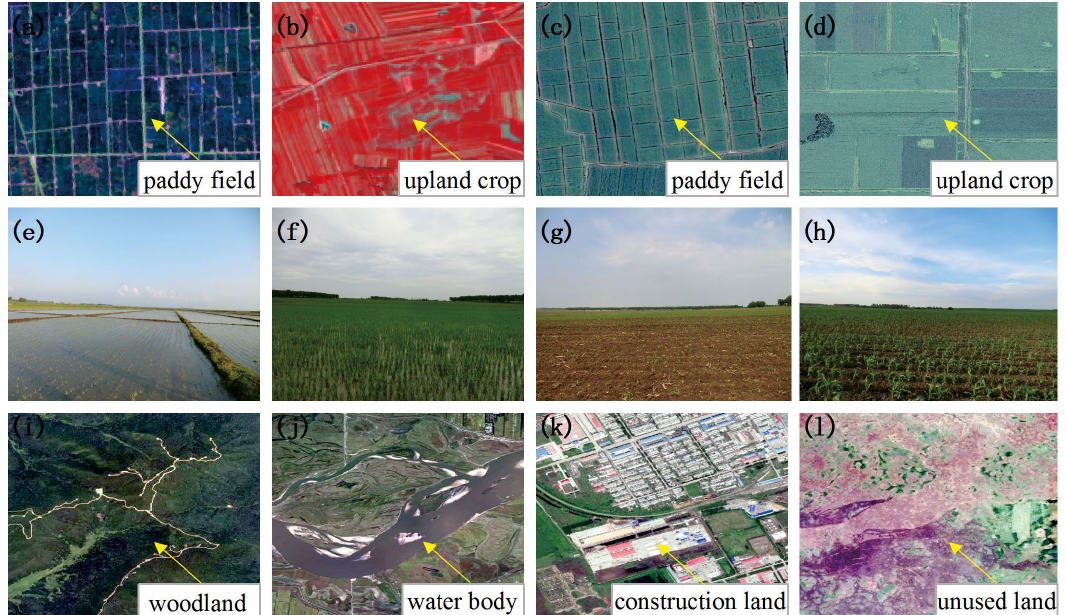
Figure 3. Validation symbols in remote sensing images and field survey photographs. ( a , b ): 30-m color composite images from Landsat TM; ( c , d ): cropping pattern (paddy field and upland crop) historical imagery archived by Google Earth; ( e , f ): survey photographs of paddy field in early June and late June 2015; ( g , h ): survey photographs of upland crops in early June and mid-June 2015; ( i – l ) Non-cropland class; including woodland ( i ); water body ( j ); construction land ( k ); and unused land ( l